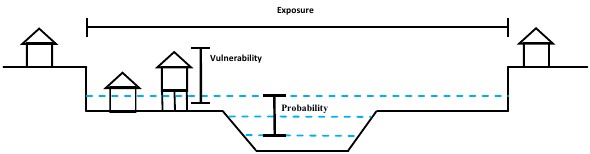
Figure 1. Cross section of a floodplain showing the components of